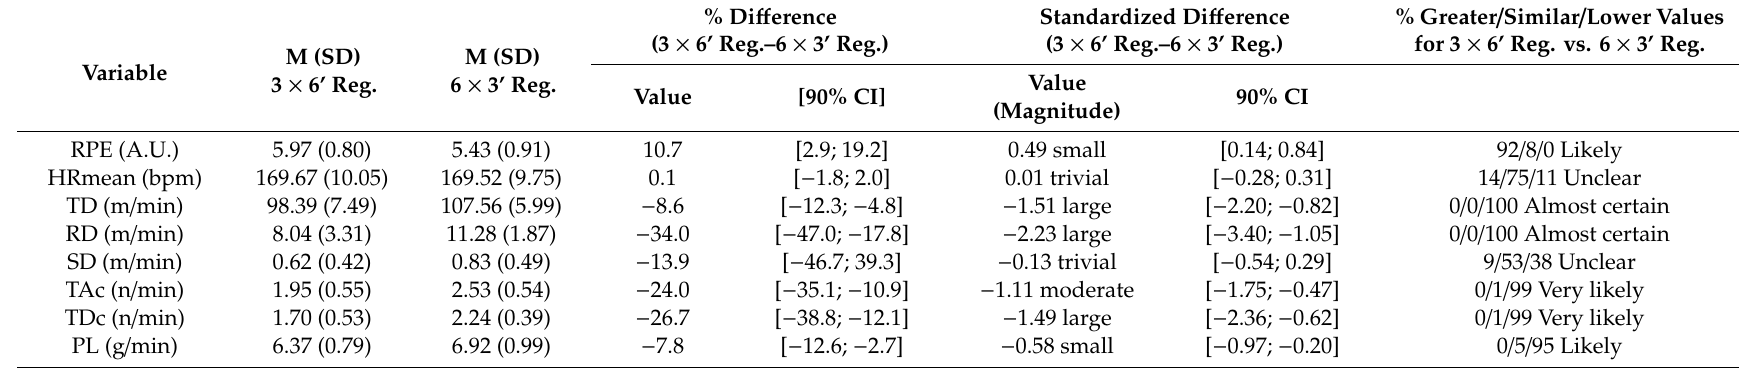
Table 2. Comparison of internal and external load variables between training regimens in terms of percentage and standardized di ff erences and the probabilities of each standardized di ff